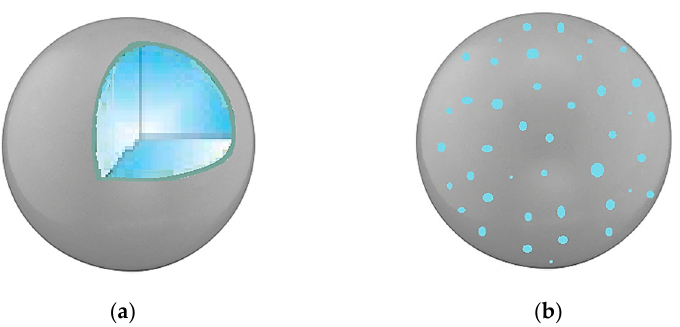
Figure 1. Possible PVP-based particles: ( a ) core–PVP shell structure (microcapsule-like structure); and ( b ) active principle dispersed into PVP matrix (microsphere-like structure).